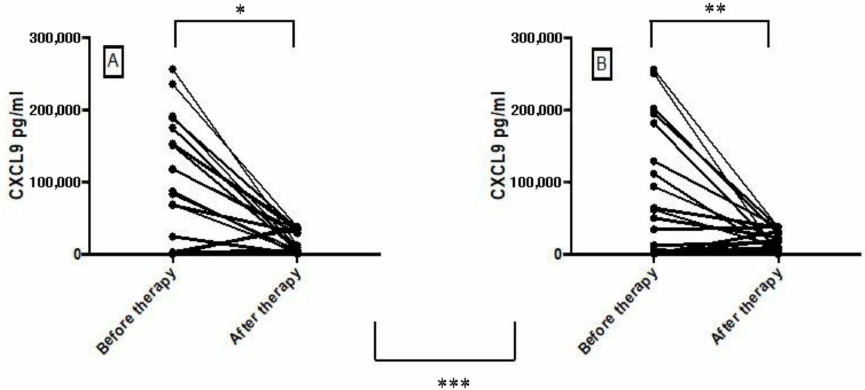
Figure 4. CXCL9 production before (Day 0) and after therapy (Day 30–40) with antimony ( A ) [ n = 25] and antimony plus pentoxifylline ( B ) [ n = 25]. The production of CXCL9 was evaluated by ELISA in supernatants of PBMCs stimulated with SLA. Statistical analysis was performed by Wilcoxon matched pairs test (* p = 0.013; ** p = 0.043) and Mann-Whitney U test (*** p =